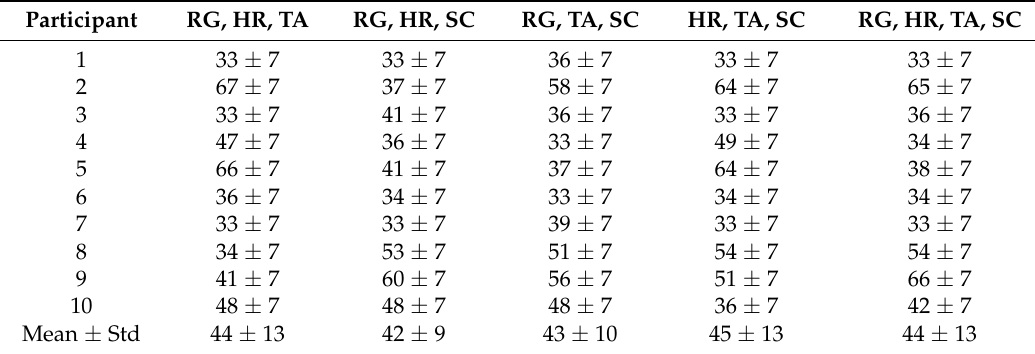
Table 5. Probability of successful detection of stress level using three or all the stress markers as features for the leave one-subject-out cross